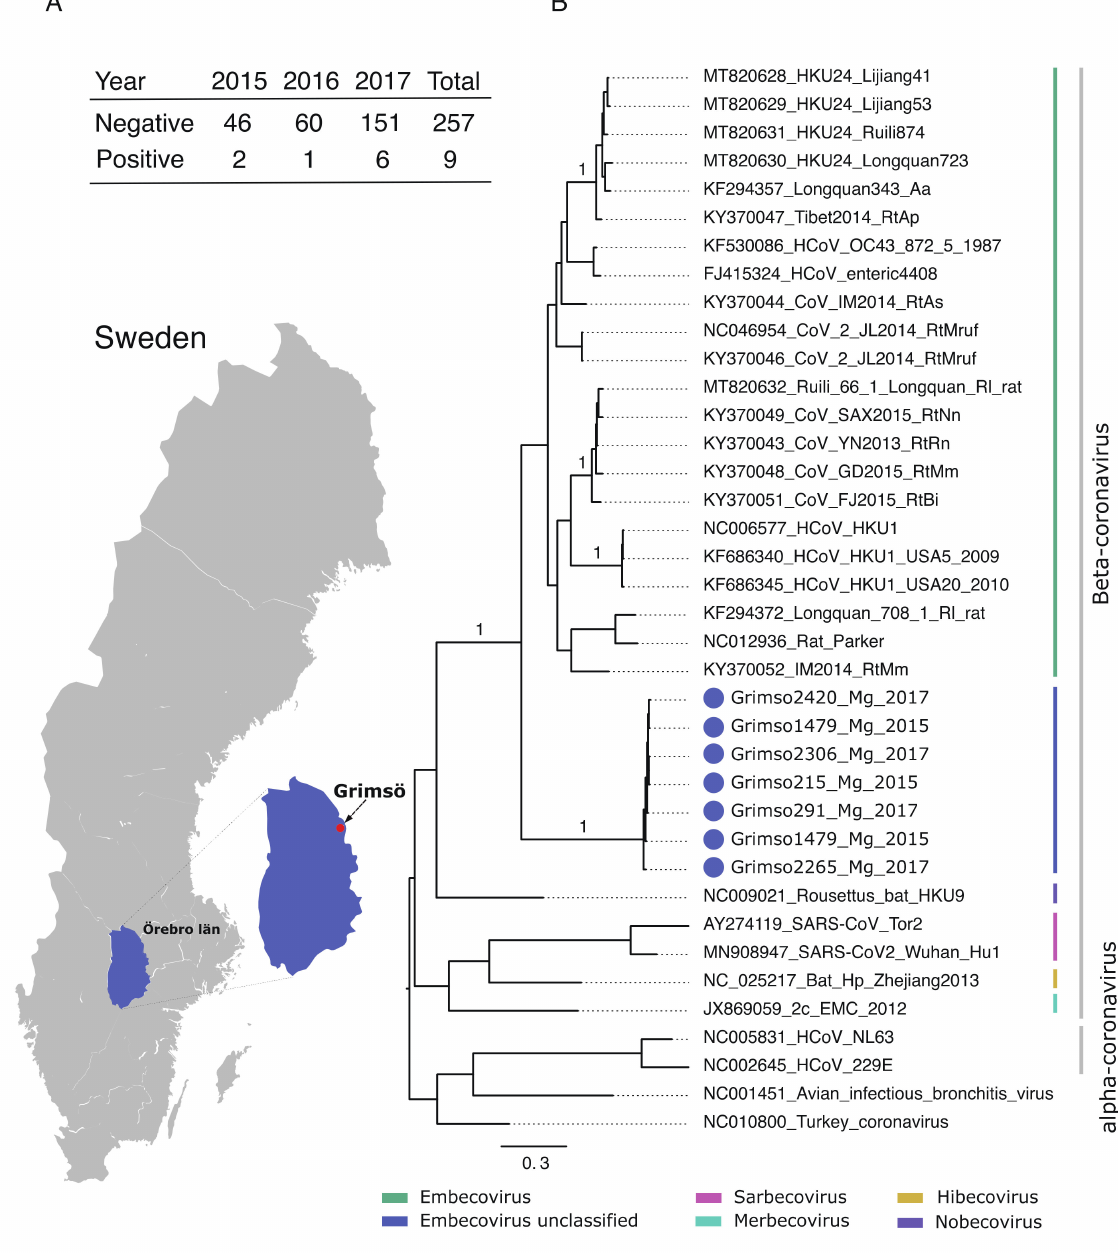
Figure 1. ( A ) Geographic map showing the province Örebro, Sweden and the site of sampling (Grimsö) where bank voles were captured. Table demonstrating the prevalence of Grimso virus from 2015 to 2017. ( B ) MrBayes midpoint root tree based on the 252 nt of the spike gene. The scale bar indicates the nt substitution per site. The numbers above the branches indicate the posterior probability. Grimso virus samples are highlighted in